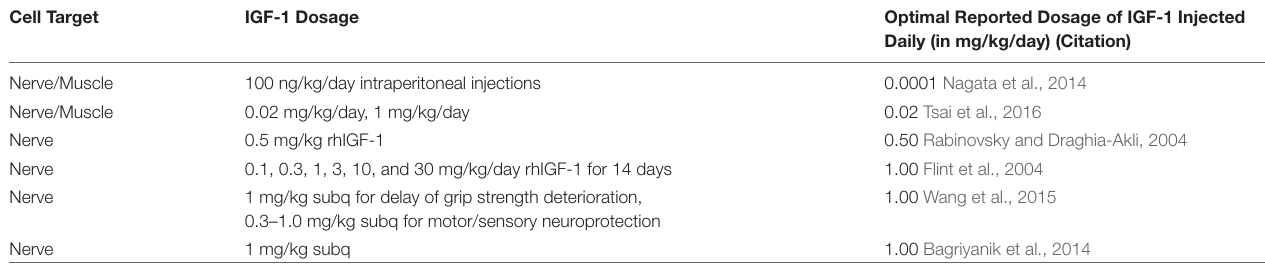
TABLE 3 | In vivo studies using systemic administration of IGF-1 (rhIGF-1, recombinant human IGF-1; subq, subcutaneously). Cell Target